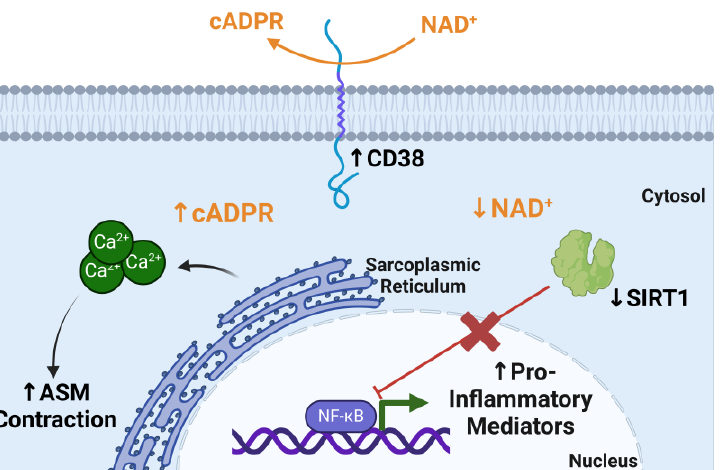
Figure 2. CD38 NAD + metabolism increases cADPR levels and limits SIRT1 activity. CD38 consumes nicotinamide adenine dinucleotide (NAD + ) to convert it to cyclic adenosine diphosphate ribose (cADPR) which is used intracellularly to induce calcium (Ca 2+ ) release from the sarcoplasmic reticulum, which allows the contraction of airway smooth muscle (ASM). Sirtuin 1 (SIRT1) inhibits NF κ B activation; however, this consumption of NAD + , the SIRT1 cofactor, limits SIRT1 deacetylase activity, which allows the production of pro-inflammatory mediators via NF κ B activation. Figure was created using BioRender.com accessed on 20 March 2023.